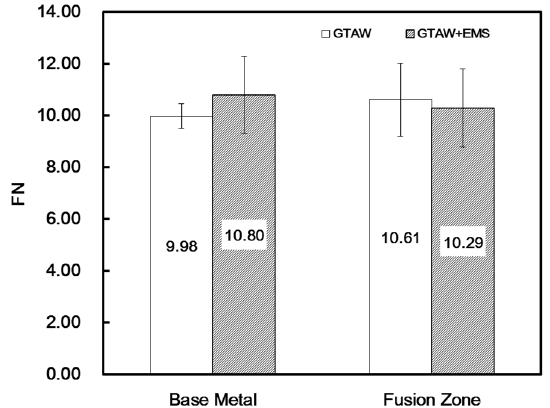
Figure 2. The ferrite number of the base metals and welds.